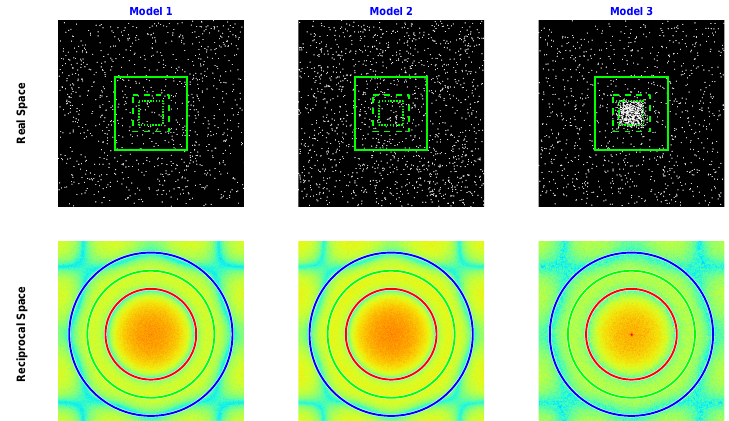
Figure 1. Matrices representing the real space configuration (top row) and the reciprocal space speckles (bottom row), in logarithmic scale, of the three different models in the initial conditions: ( left ) Real space representation of Model 1, where one type of particle is uniformly distributed in the 2D matrix at time t = 0; ( middle ) Model 2: two types of particles of same shape and different diffusion constant are uniformly distributed in the matrix; ( right ) Model 3: one type of particle is uniformly distributed in the 2D matrix and and a second type of slower particles are confined (in time t = 0) in a small area in the middle of the matrix. The green squares on the top row images represent the different mask sizes that have been applied (masks 1, 2 and 3 in the main text). The circles on the bottom row figures indicate the distances (in reciprocal space) at which the OTCFs have been extracted (250, 350, & 450 in the main text—These correspond respectively to Q values of 0.11, 0.15, and 0.20 nm − 1 for a particle of 80 nm